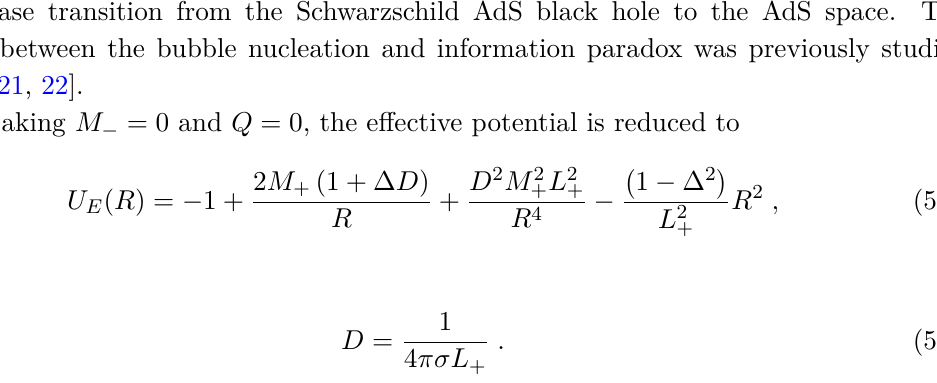
Figure 3 . The effective potential U E ( R ) of the bubble nucleation in SAdS black hole for different black hole mass M + . In this plot, G = 1 , L + = 1 . 4 , L − = 1 , and σ = 1 mass is M c = 0 . 0863 . When 0 < M + < M c , the effective potential has two intersections with the R axial. When M + > M c , there is no